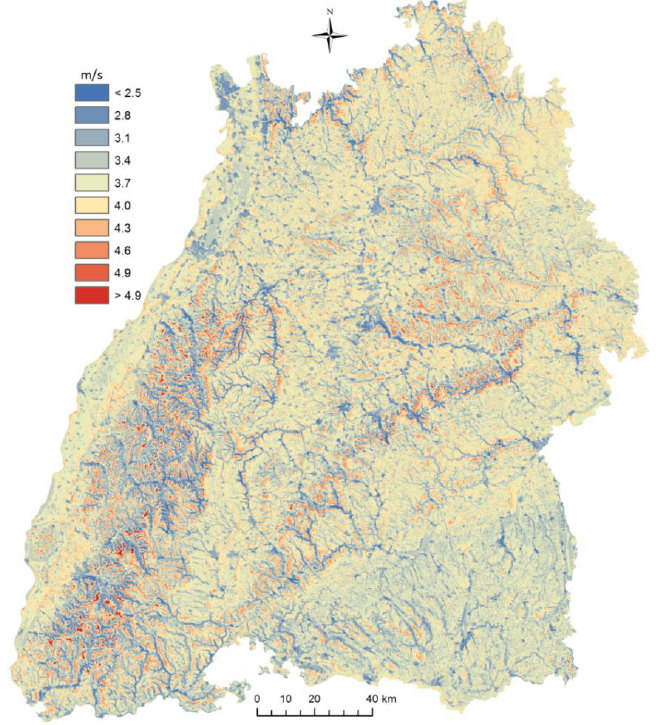
Figure 4. Median of modeled wind speed in 100 m AGL ( values indicate highest class values.